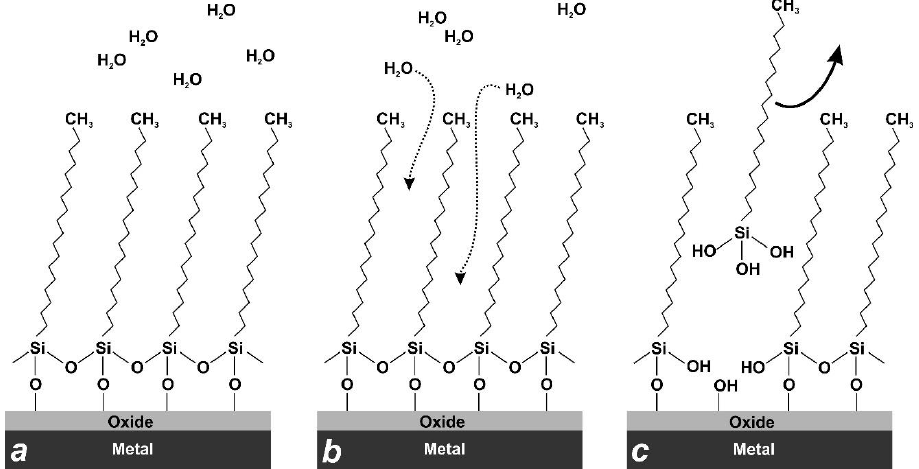
Figure 1. Schematic presentation of self-assembled one-layer ODTMS coating formed on metal oxide substrate. ( a ) Dense ODTMS layer with hydrophobic methyl-groups that repel water. ( b ) Water molecules gradually penetrating inside the layer over time to attack and hydrolyze the Si-O-Si and Si-O-Al bonds. ( c ) Loose alkylsilanol molecules are released from the coating as a result of hydrolysis, leaving unprotected sites.